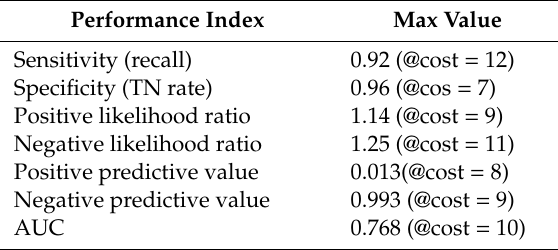
Table 5. The maximum value of each performance index in our machine learning model by